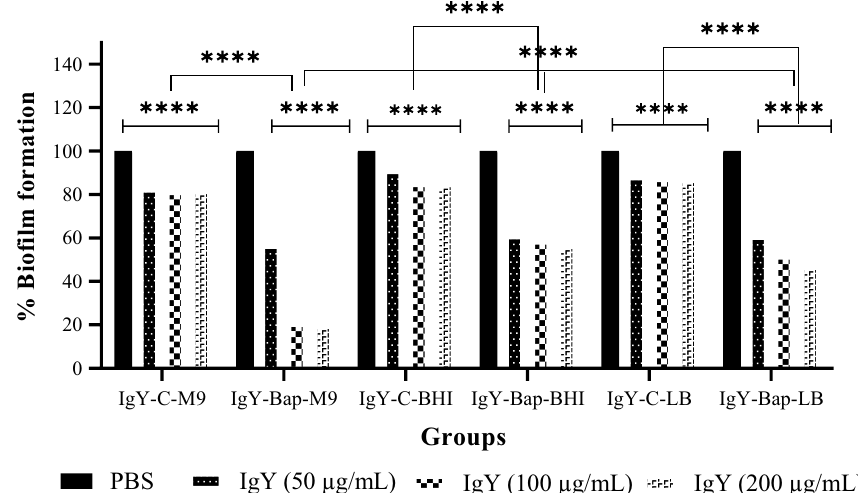
Figure 3. Inhibition of biofilm formation by a clinical strain of A. baumannii in M9, BHI, and LB media in the presence of various concentrations of prophylactic IgY. Formation of biofilm in different media against each IgY-Bap group compared with that of PBS as well as IgY-C groups. The IgY-Bap groups were also compared independently and with each other ( p < 0.0001).